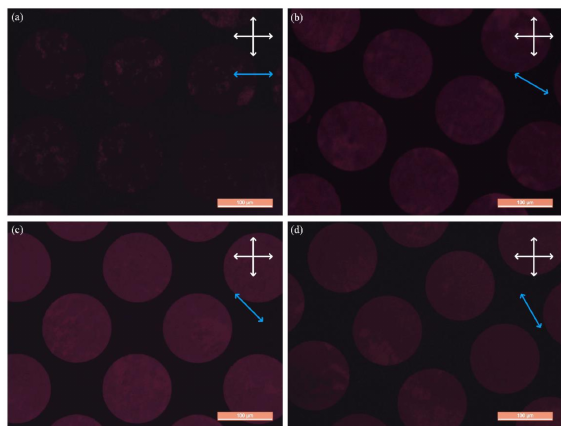
Figure 5. Optical characterization of the LC molecules alignment of EC-LCMLA. ( a ) In the initial state, the short side of EC-LCMLA (i.e., the selected easy axis direction) was parallel to the transmission axis of polarizer. ( b – d ) The captured polarized optical microscope (POM) images when the EC-LCMLA rotated by 30 ◦ , 45 ◦ and 60 ◦ , respectively. The white cross arrows represent the transmission axis directions of the analyzer and the polarizer, and the blue arrow represents the short side of the SCG-silica substrate (i.e., the selected easy axis